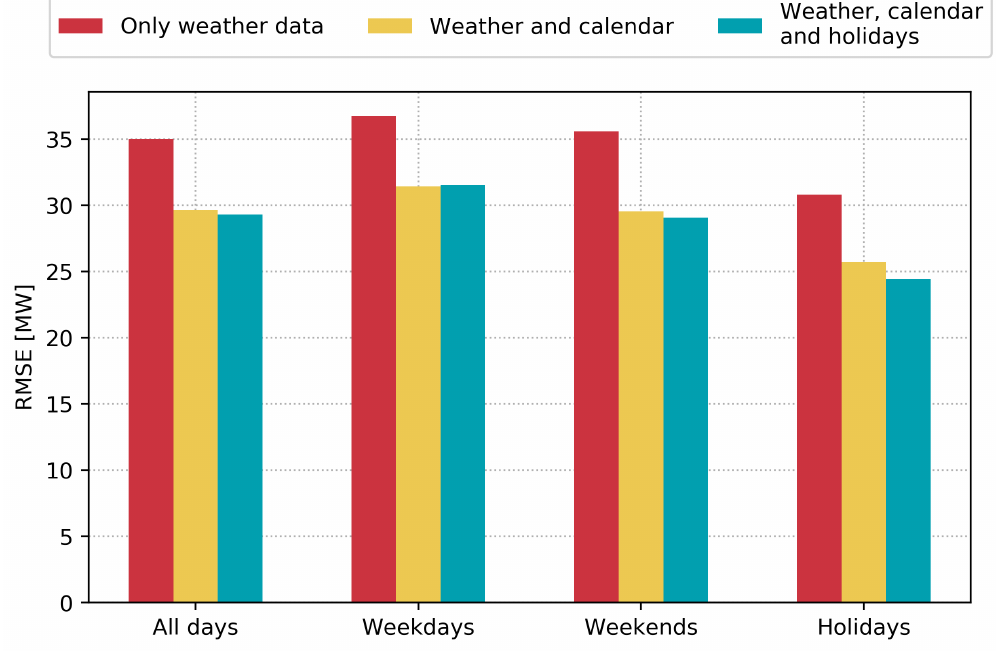
Figure 7. Forecast performance of the SVR model on the year 2016 using real weather forecasts, calendar, and holiday data. The second and third group of bins refer to weekdays and weekends that are not also included in holidays. Holidays refer to all days that are observances, national holidays, or school holidays (see Table